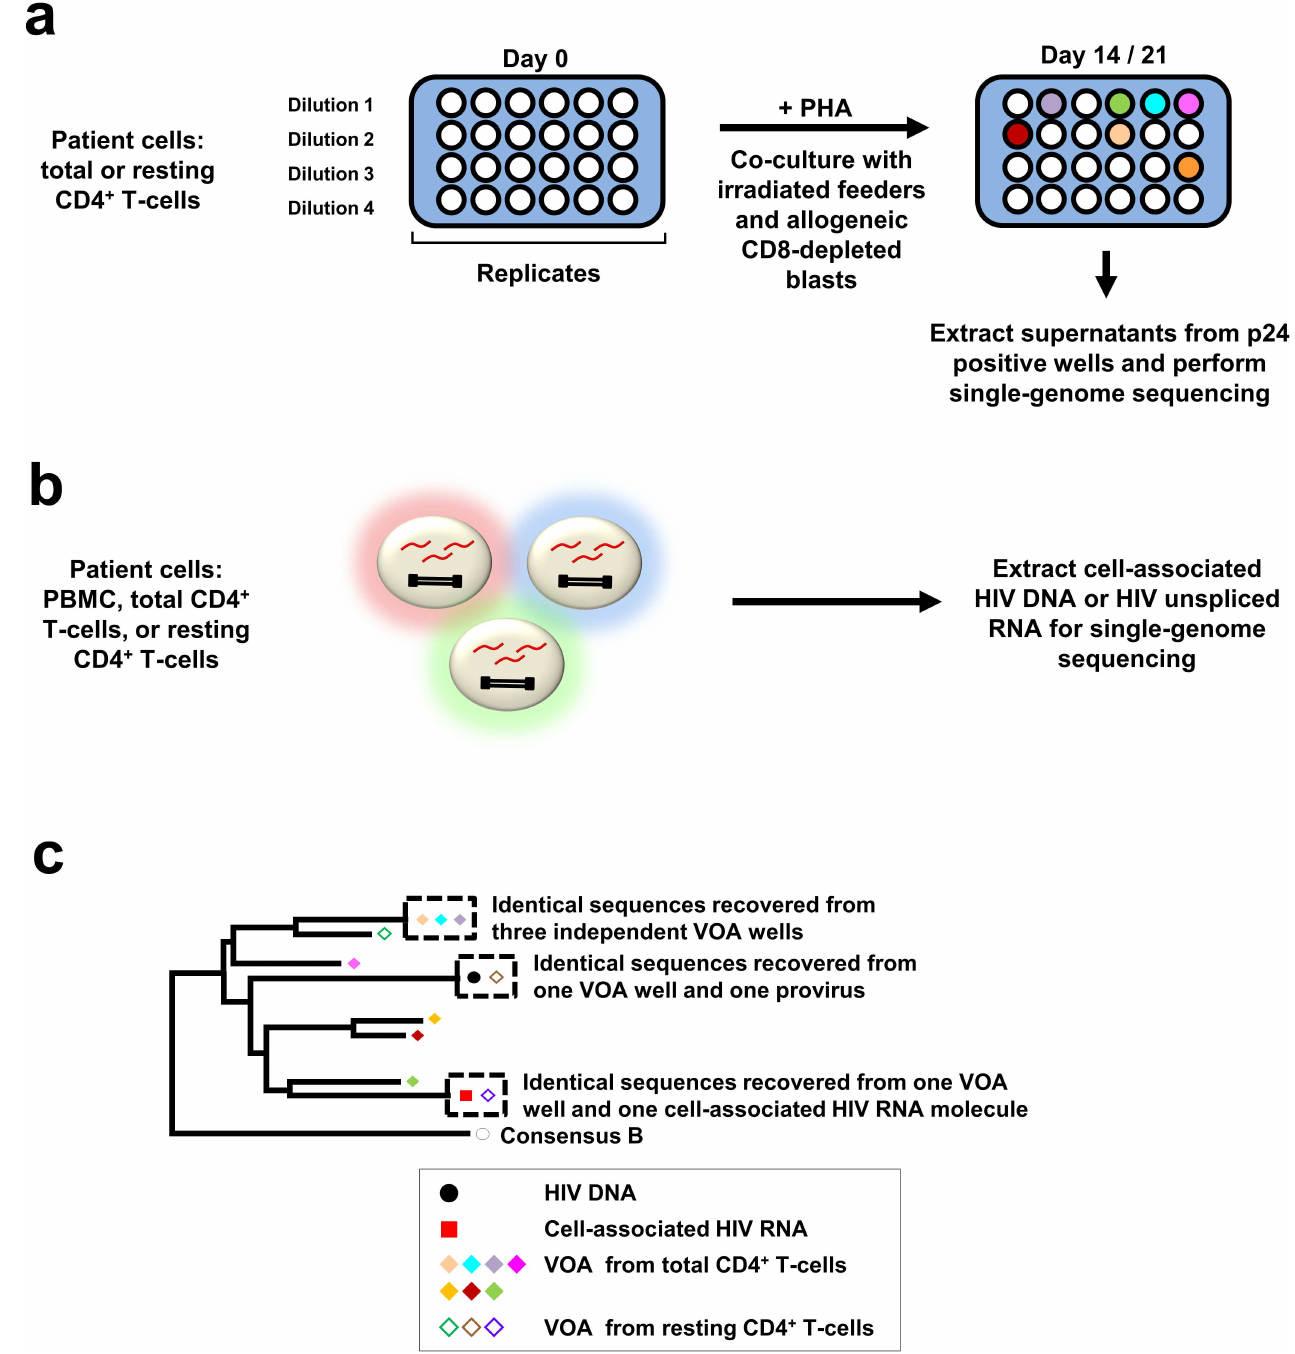
Fig 1. Schematic of experimental approach. (a) To perform quantitative viral outgrowth assays (VOA), donor CD4 + T cells (resting or total) were serially diluted, stimulatedwith PHA, and co-culturedwith irradiatedfeeder cells and CD8-depleted allogeneicblasts from HIV-negative donors for 14 to 21 days. Single-genome sequencing (p6-PR-RT or near full-length)was performed on supernatants from p24-positive wells, and the sequencesfrom the different wells were analyzedfor identicalmatches. (b) Single-genome sequencing was performed on unculturedblood mononuclear cells to obtain p6-PR-RT sequencesfrom HIV DNA and/or unsplicedHIV RNA to search for identicalsequencematches to RNA sequencesfrom p24-positive VOA wells. (c) Schematic showinghypothetical examplesof identicalsequencematches betweensingle-genome sequencesfrom p24-positive wells, HIV DNA, and cell-associated HIV RNA analyzedby neighbor-joining distanceanalysis.